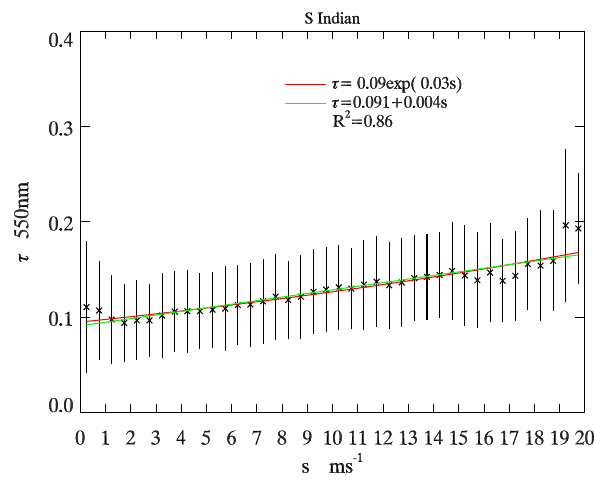
Fig. 8. Relationship between wind speed s and AOD τ over the